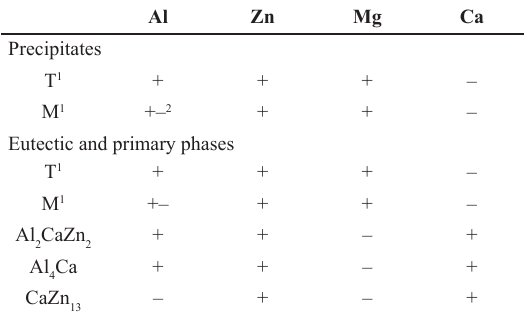
Table 3. Possible distribution of elements between the phases in alloys of the Al-Ca-Zn-Mg system in Al-corner 2,12,22,23